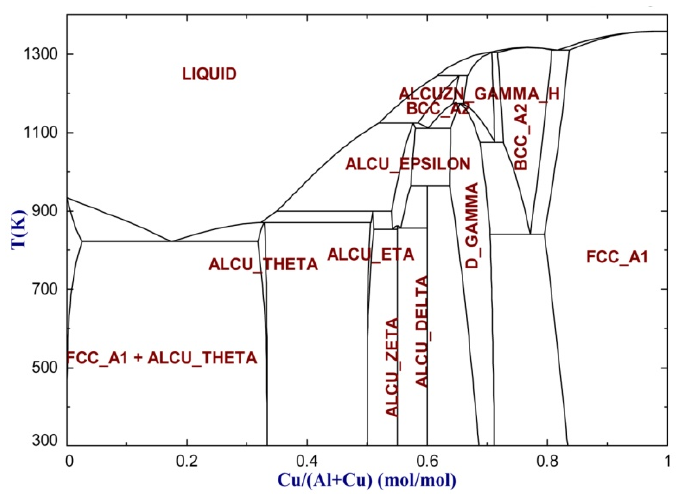
Figure 3. Cu-Fe phase diagram (FactSage 7.3).